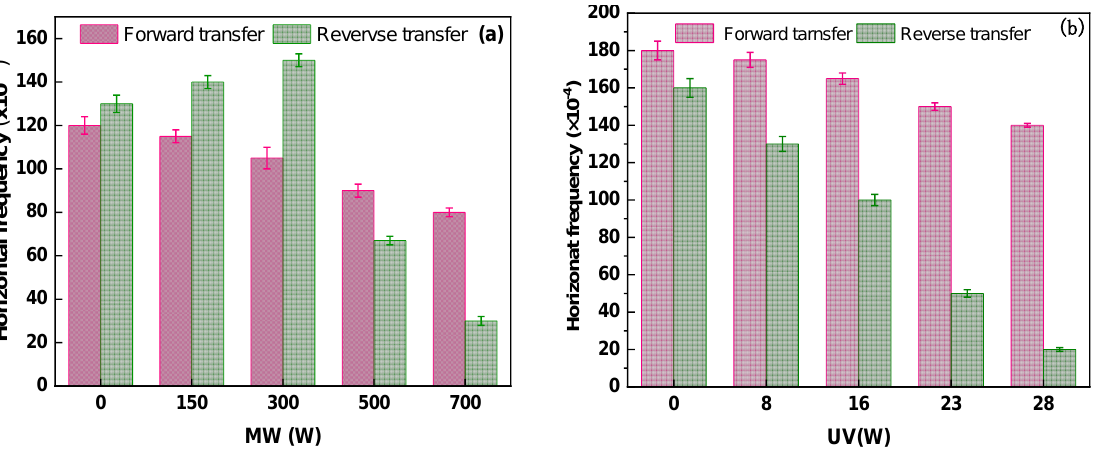
Figure 4. Effect of various power outputs on the forward and reverse transfer frequency under ( a ) MW or ( b ) UV irradiation. The concentration of bacteria was 10 8 CFU/m 3 , the donor/recipient ratio was 1:1, and the reaction time was 16 h. The error line indicated the standard deviation of the three repeated tests.